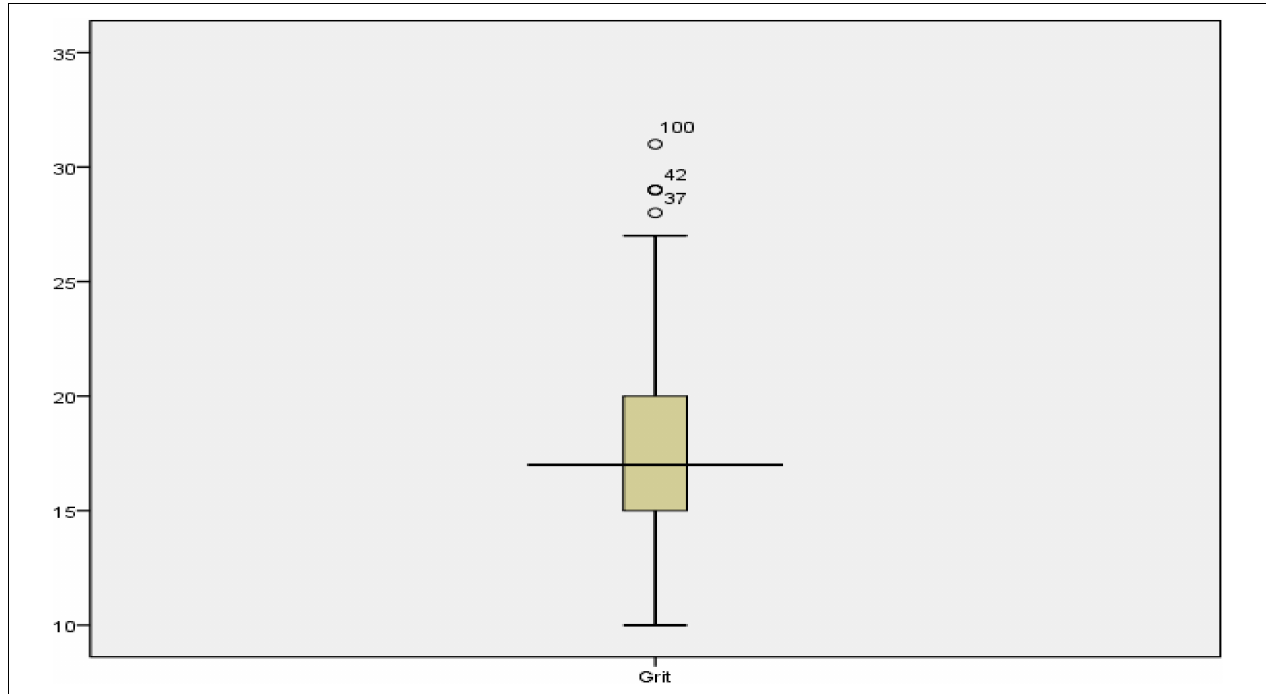
FIGURE 3 | The boxplot for grit